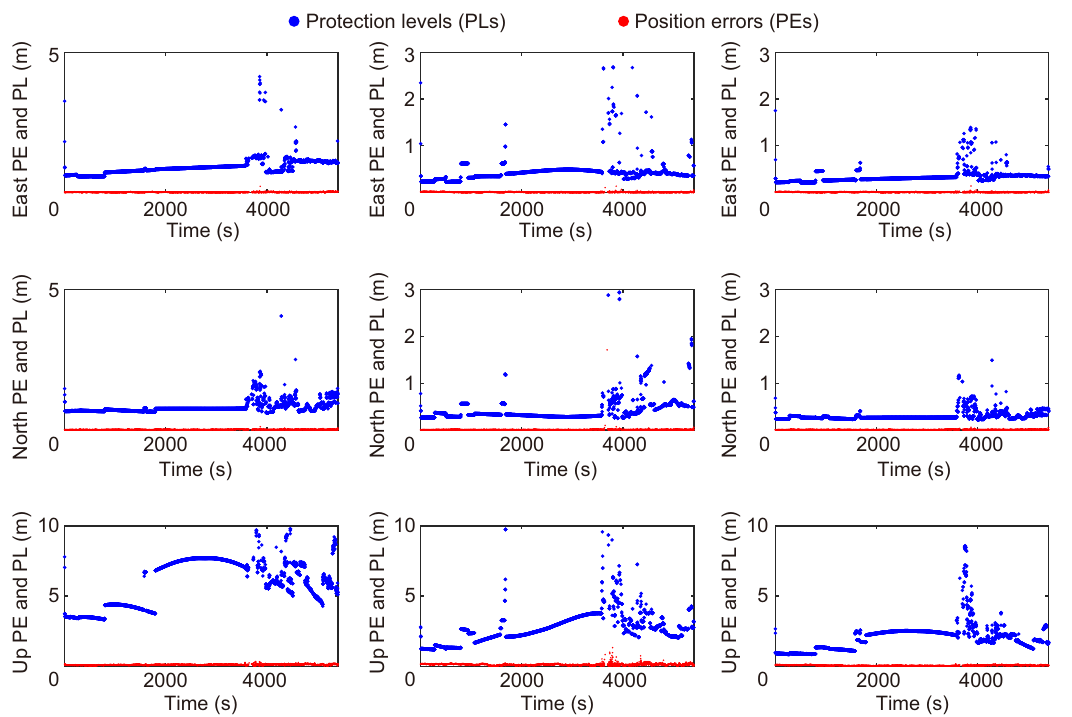
Fig. 10 Performance of the third kinematic dataset for PPP-WAR model with regional atmospheric corrections (left), PPP-AR model (middle), and PPP-RTK model (right)